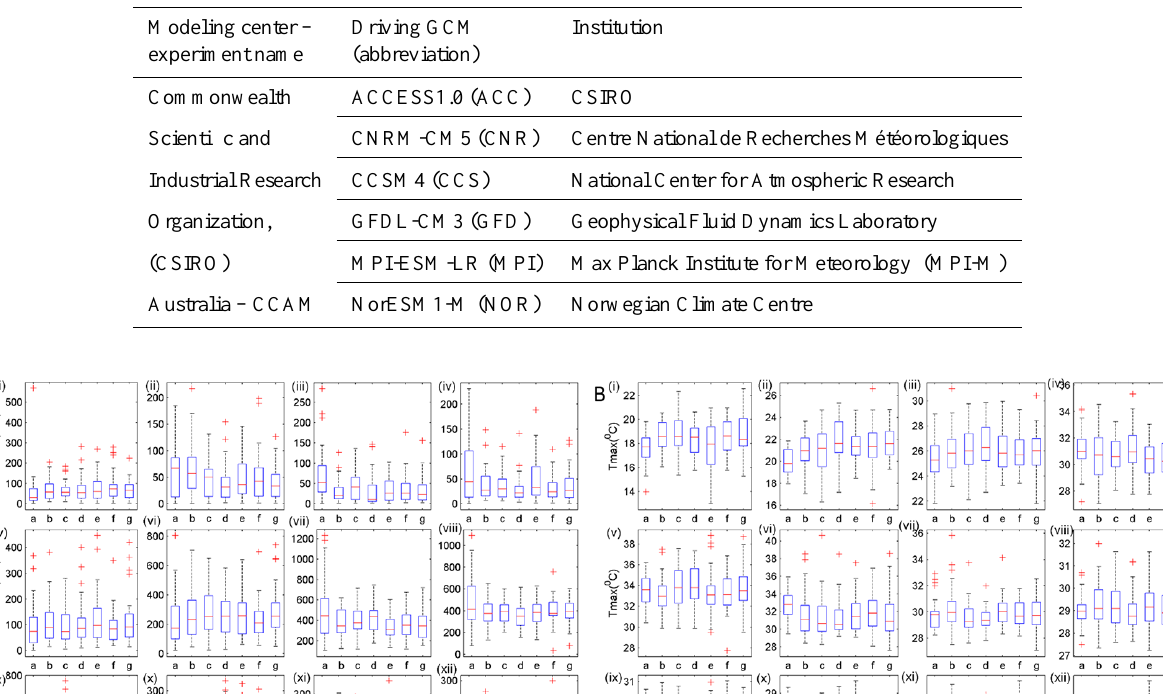
Table 1. GCMs from the CORDEX project used in the present study.